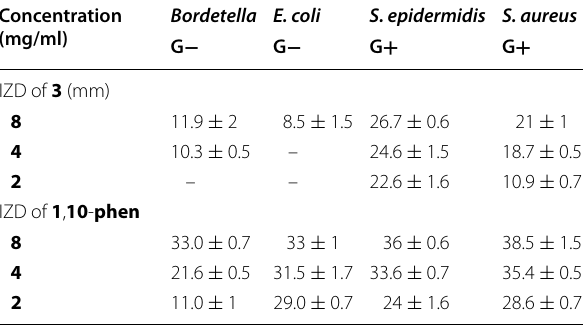
Table 4 Comparison of anti-bacterial activity of complex 3 with 1,10-phen